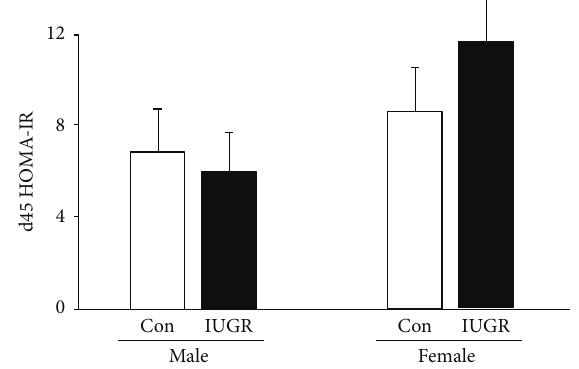
Figure 7: HOMA-IR. IUGR does not alter HOMA-IR in male or female rats at d45. Results are control (white bars) and IUGR (black bars). Errors are SD. 𝑛 = 4